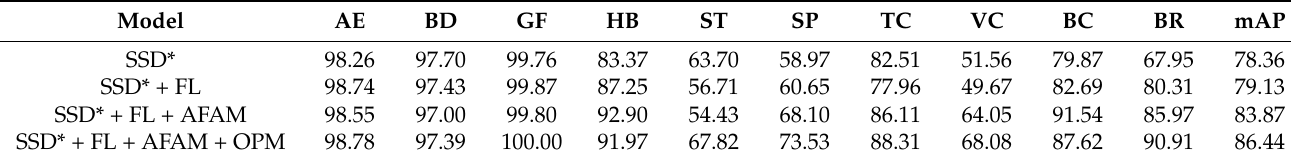
Table 4. Ablation experiments in the NWPU VHR-10